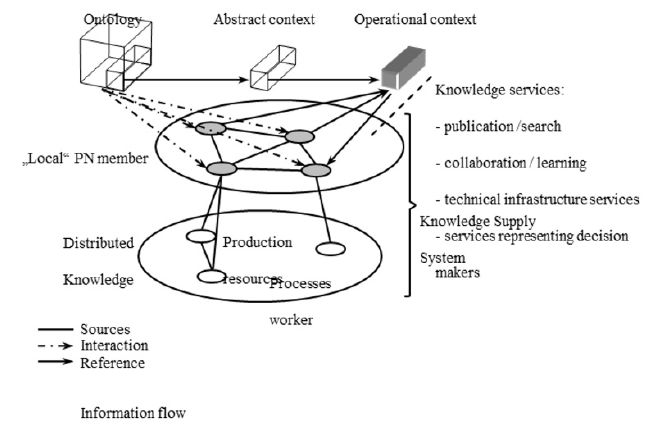
Fig. 3. Generic scheme of knowledge supply